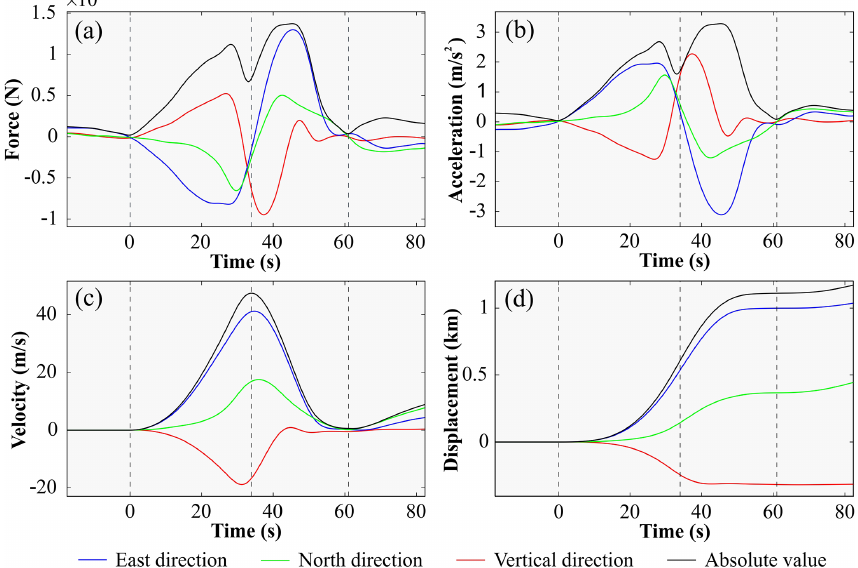
Figure 8. Dynamic inversion used to obtain the Baige landslide characteristics: (a) inverted force–time history, (b) estimated acceleration distribution over time, (c) reconstructed velocity distribution over time from the inverted landslide force–time history, and (d) reconstructed displacement distribution over time from the inverted landslide force–time history. Corresponding absolute values are shown as black lines. Dashed vertical black lines mark the landslide start and end times (the left and right lines) and the time that the sliding mass reached the maximum speed (the middle